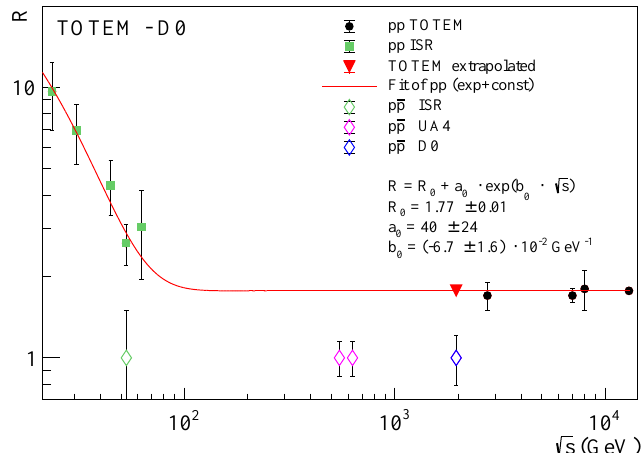
Figure 2: R Ratio of the elastic d σ/ dt cross sections at the bump and the dip as a (cid:112) s for pp and p ¯ p . (Figure reproduced from Ref. [ 2 ] ). interactions function of R value from pp TOTEM elastic data at 1.96 TeV is displayed as a red triangle. On the contrary, the R values for p ¯ p from ISR, Sp ¯ pS and D0 measurements are equal to 1.0, that leads to more than 3 σ difference between pp and p ¯ p elastic data [ 3,4,12–14 ]